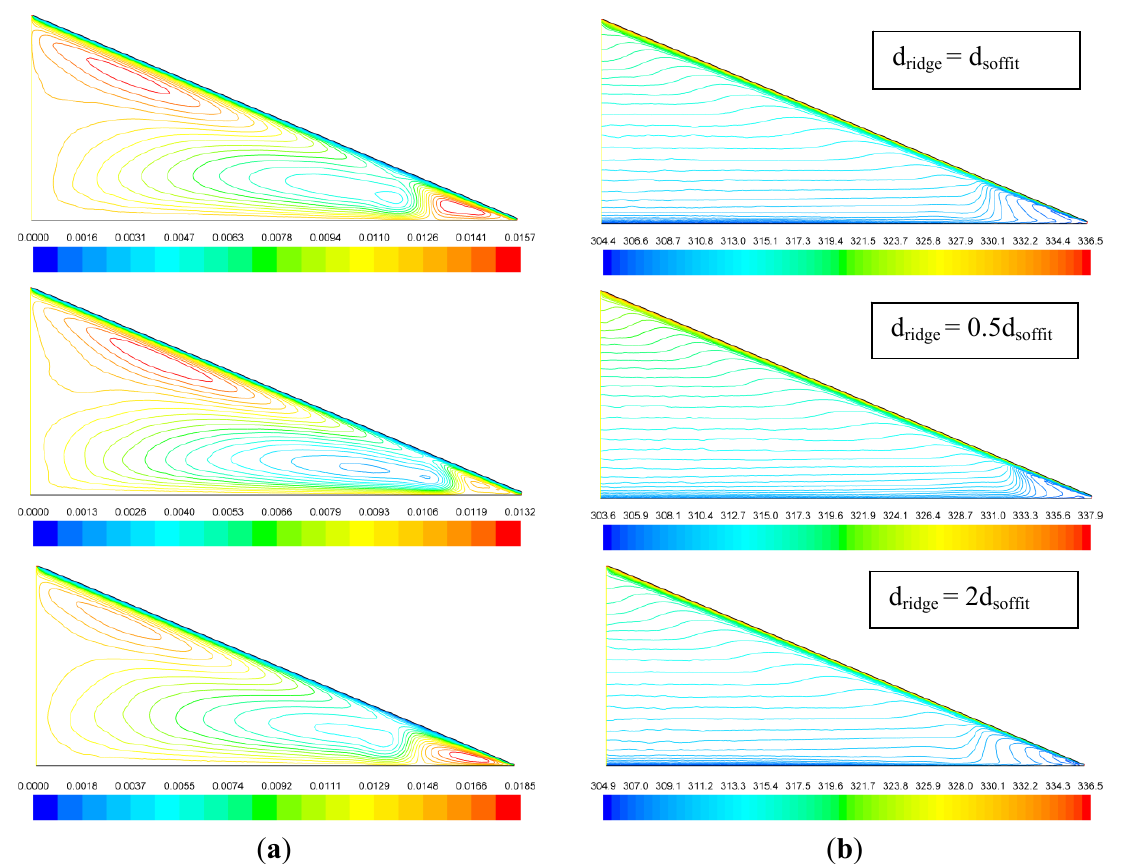
Figure 5. Comparsion of predicted ( a ) streamlines (in kg/m s) and ( b ) isotherms (in K) between balanced attic ventilation case and two cases of unbalanced attic ventilation at ventilation ratio